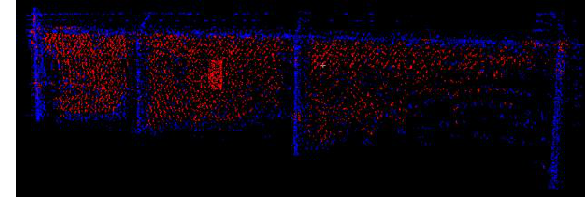
Figure 16. Segmentation results on fence achieved by the proposed method